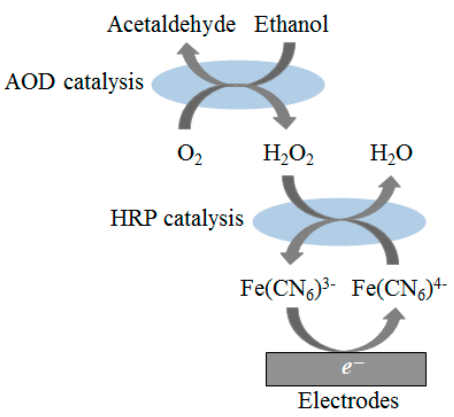
Figure 1. Enzymatic reaction at the surface of ChrSPCEs in ethanol detection.